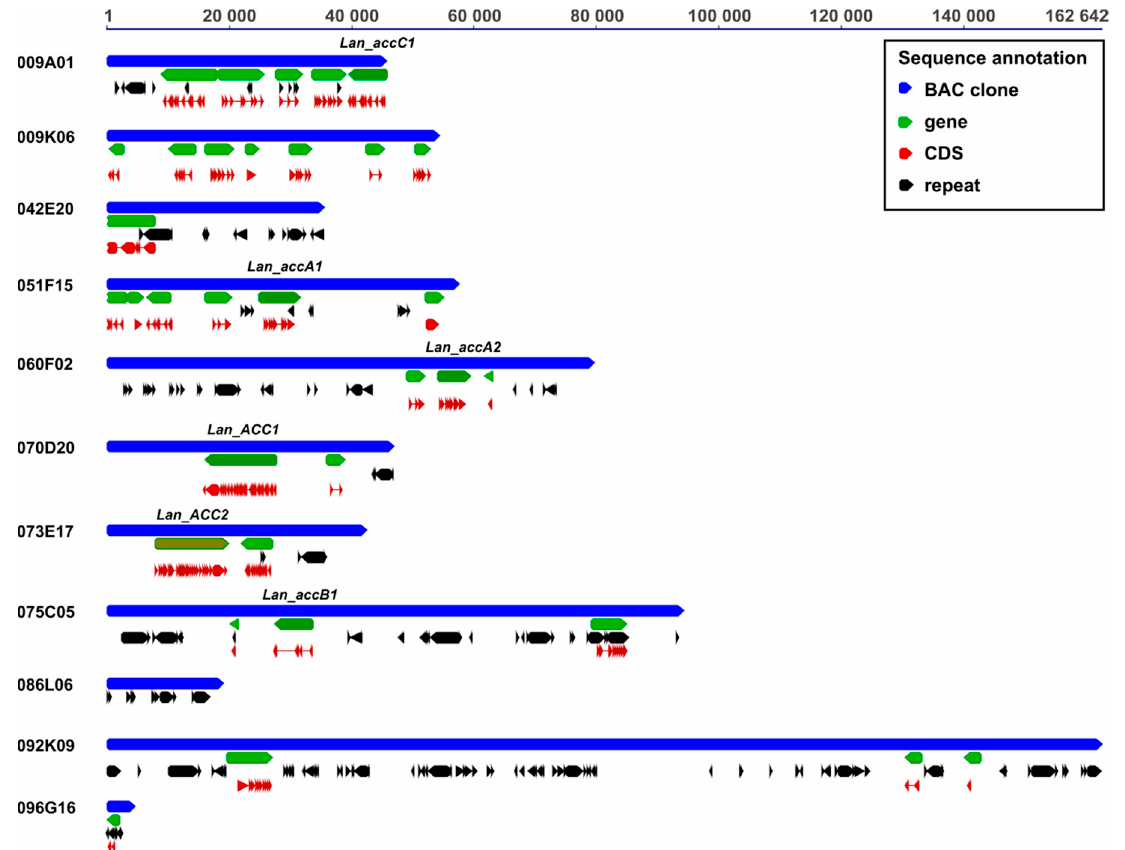
Figure 2. Annotation of L. angustifolius BAC sequences. Particular elements are marked by color: blue, BAC clone sequences (009A01, 009K06, 042E20, 051F15, 060F02, 070D20, 073E17, 075C05, 086L06, 092K09, 096G16); black, repetitive elements; green, genes; red, coding sequences. All sequences are drawn to scale provided at the top of the figure